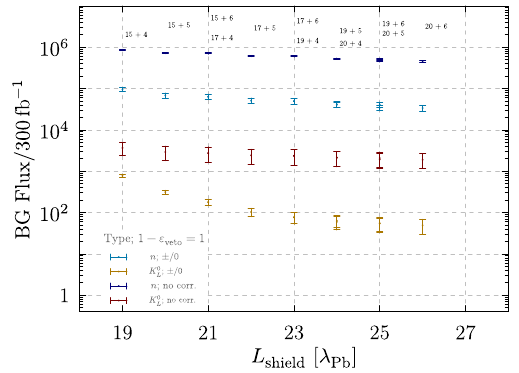
Fig. 25 Variation of neutron and K 0 background fluxes with kinetic L energy E kin > 0 . 4GeV versus total Pb shield depth in λ Pb under varia- tion of the shield configuration with no shield veto (1 − ε veto = 1), including the charged-neutral correlation veto in the detector (light palette) and without the charged-neutral correlation veto in the detector (darkpalette).Foreachvalueofthetotalshielddepth,the(possiblymul- tiple) corresponding configurations “ L pre-veto + L post-veto ” are shown by the adjacent labels in units of λ